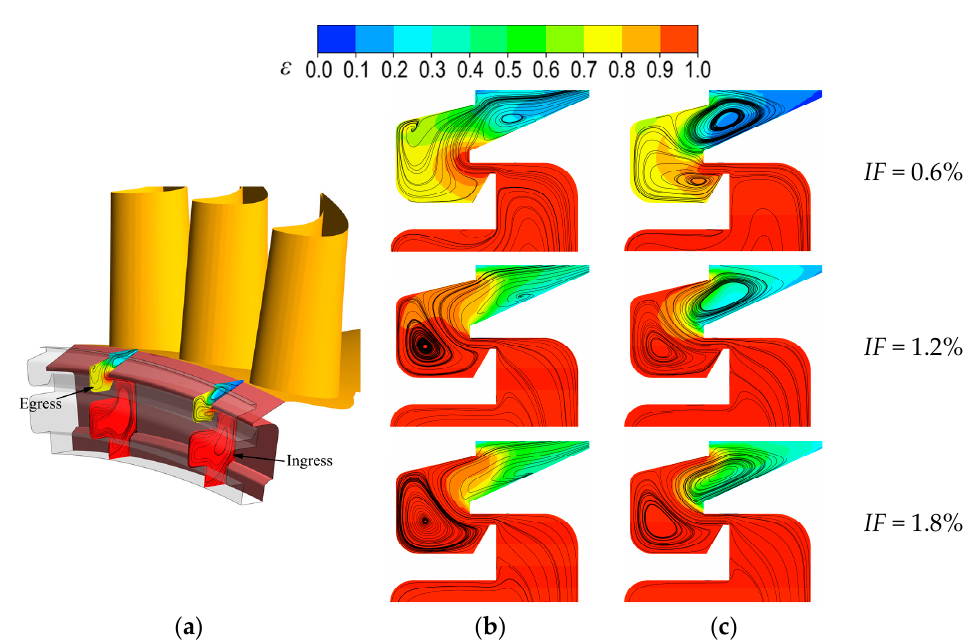
Figure 17. Time-averaged sealing efficiency contour distributions and the surface streamlines at the sections of ingress and egress in Seal-A: ( a ) position of the disk cavity sections; ( b ) egress section; ( c ) ingress section.